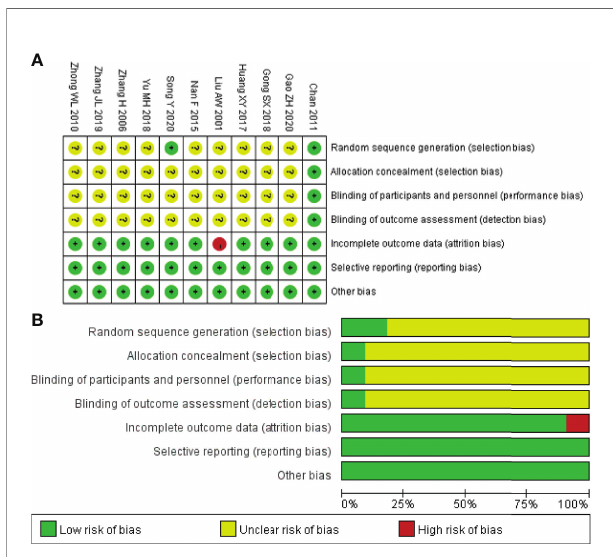
FIGURE 2 | Risk of bias summary (A) and diagram (B) .